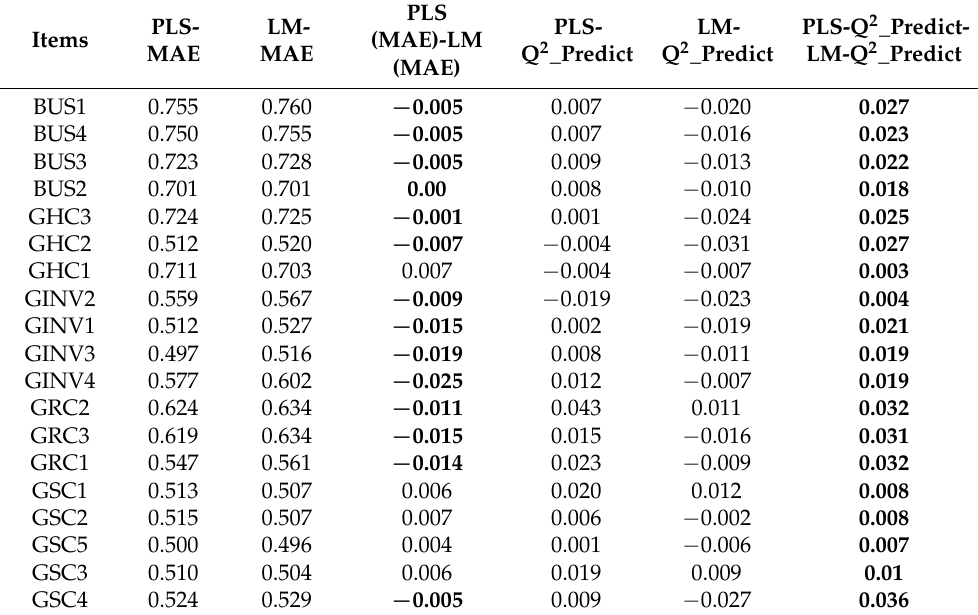
Table 8. Assessment of PLSpredict power.